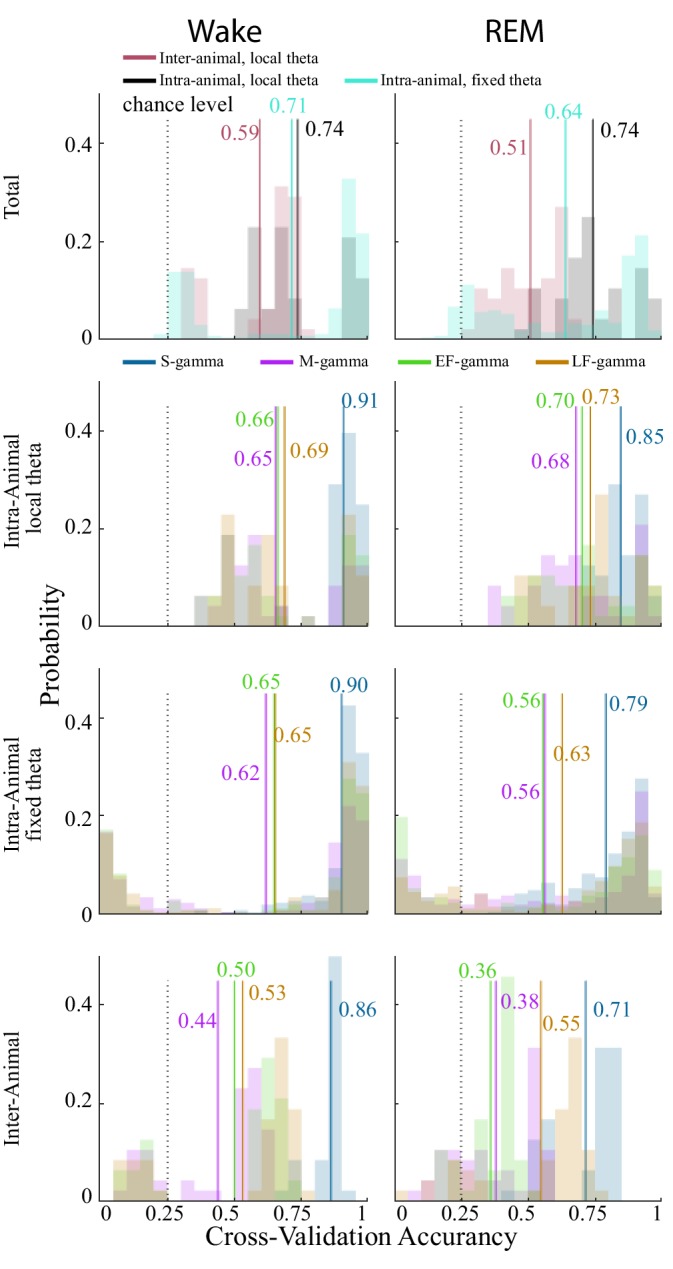
Cross-validation for individual theta cycle assignments.The top row represents the distribution of cross-validation accuracy of all data including inter-animal cross-validation (red), intra-animal cross-validation (black/gray), and intra-animal cross validation with a single fixed reference theta channel (fixed theta, light blue). The second (FPP calculated with local theta on the same channel) and third rows (FPP calculated with a fixed theta channel) show the intra-animal cross-validation separated for samples in each TG state (S-gamma, dark blue, M-gamma, purple, EF-gamma, green, LF-gamma, orange). The fourth row shows the inter-animal cross-validation separated for samples in each TG state. Solid line: mean; dash line: chance level.